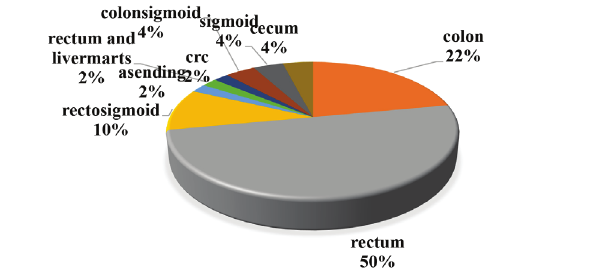
Figure 1. Histopathology of colorectal cancer patients based on differentiated adenocarcinoma.